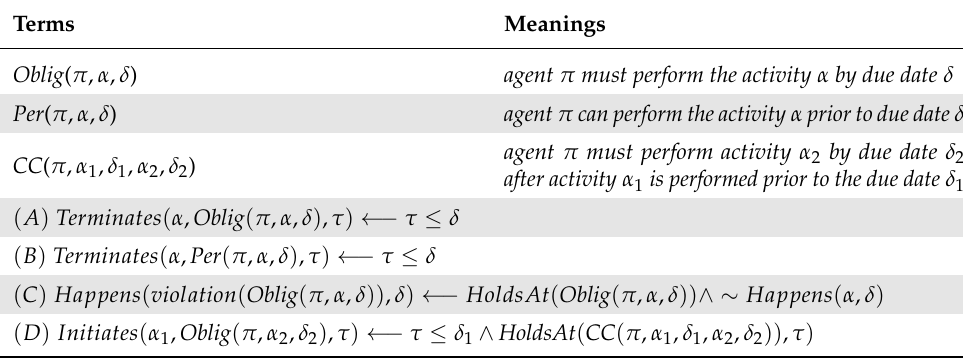
Table 14. PENELOPE ’s deontic properties